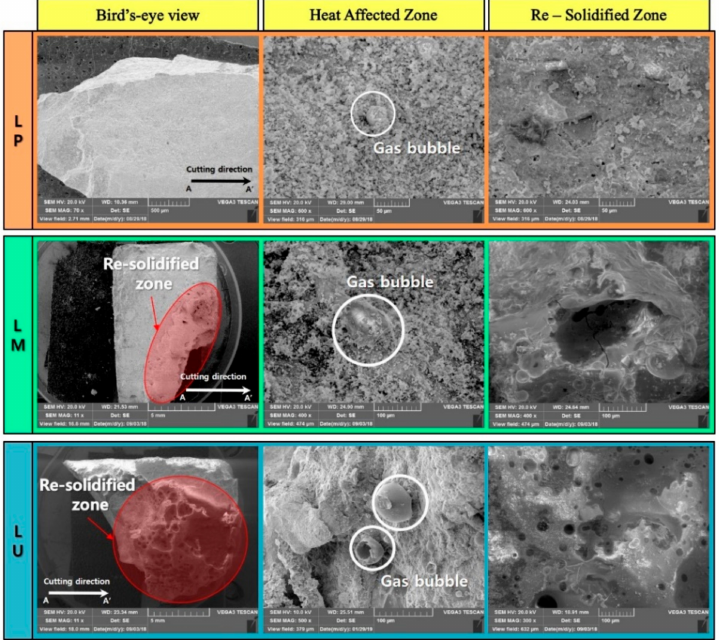
Figure 4. SEM images of the cut surface on the laser-processed specimen after the laser